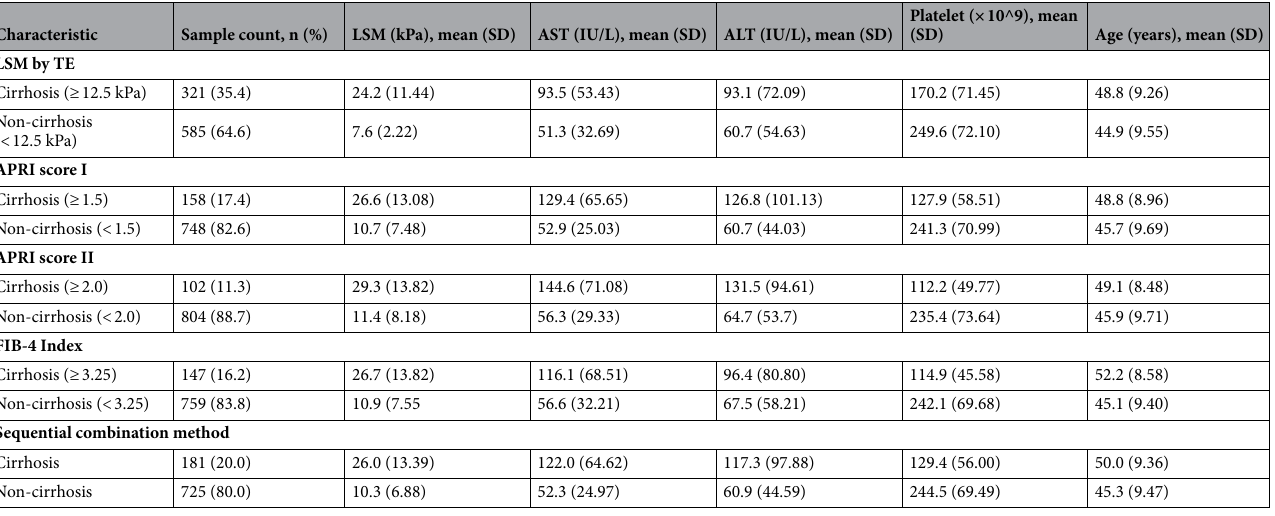
Table 2. Distribution of cirrhotic status by transient elastography, APRI, FIB-4 and the sequential combination method (N = 906). LSM liver stiffness measurement, TE transient elastography, AST aspartate